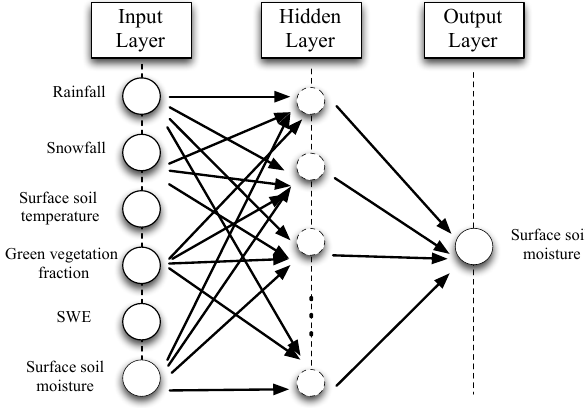
Figure 8. Structure of the artificial neural network employed in the synthetic DA